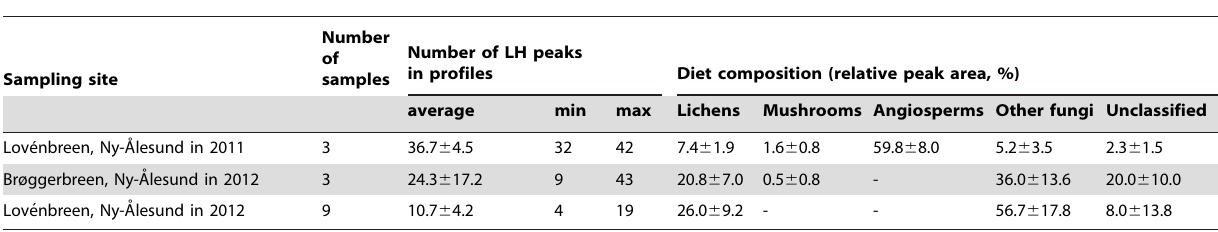
Table 3. Number of LH peaks in LH profiles and estimated of diet composition on different sampling regions in between 2011